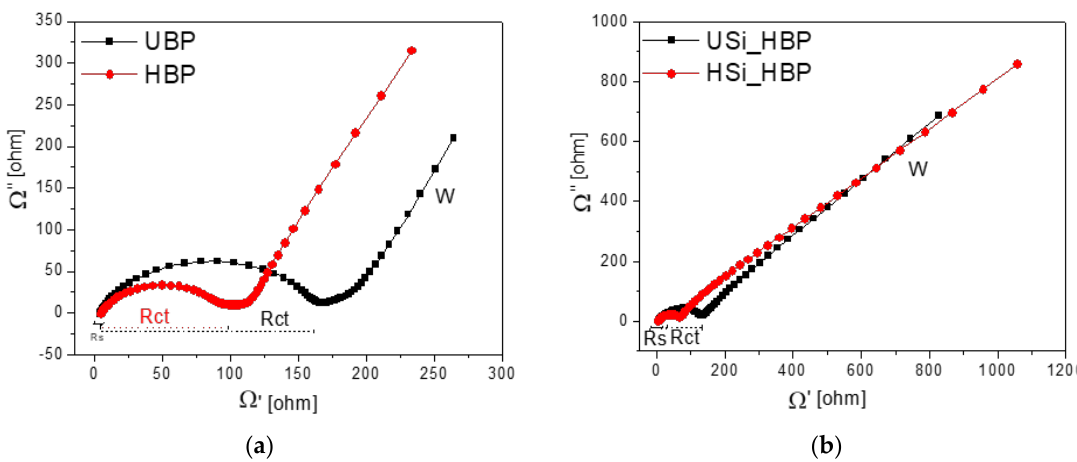
Figure 7. Electrochemical impedance spectra of the ( a ) buckypapers and the ( b ) heat-treated Si_buckyaper electrodes at fifth discharge cycles at a frequency range of 1 to 10 MHz with cutoff of 0.15 V.